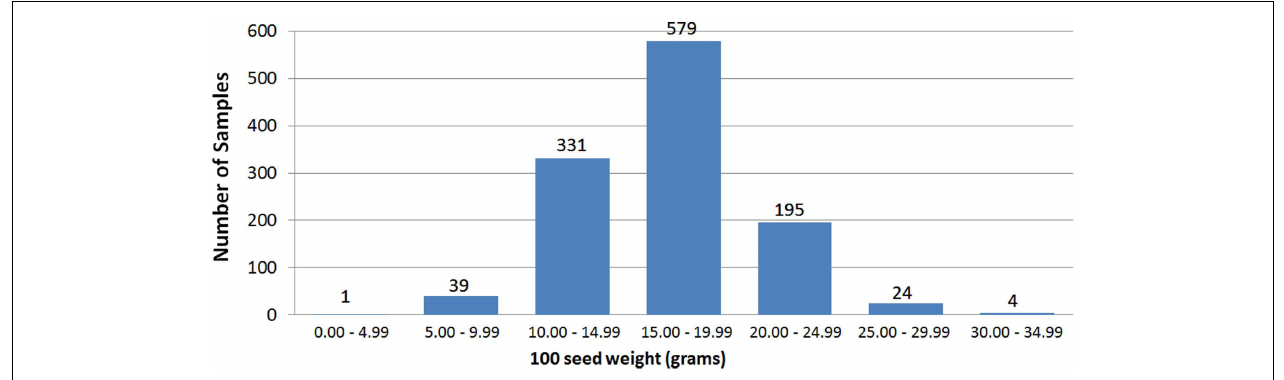
FIGURE 2 | Phenotypic distribution of seed size among eight bi-parental populations of cowpea.